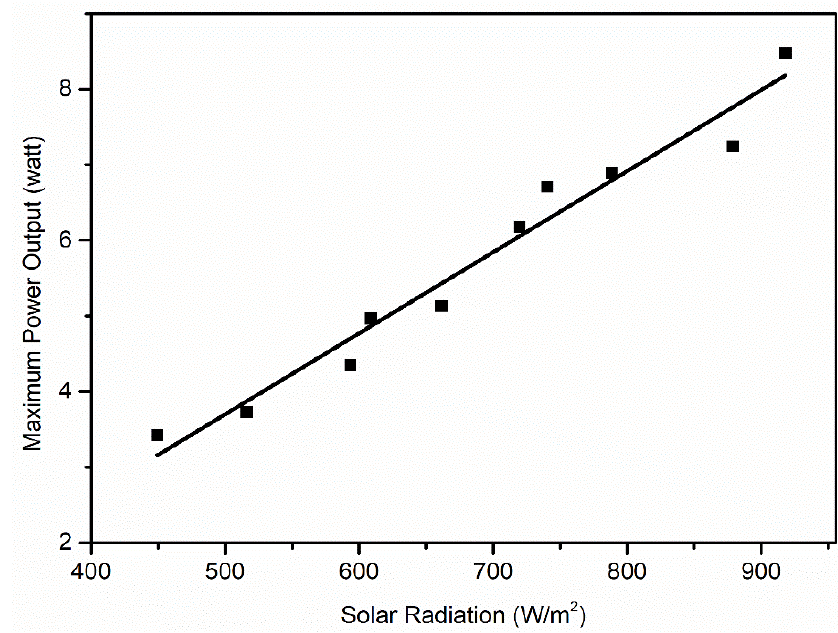
Figure 9. Output power with solar irradiance .